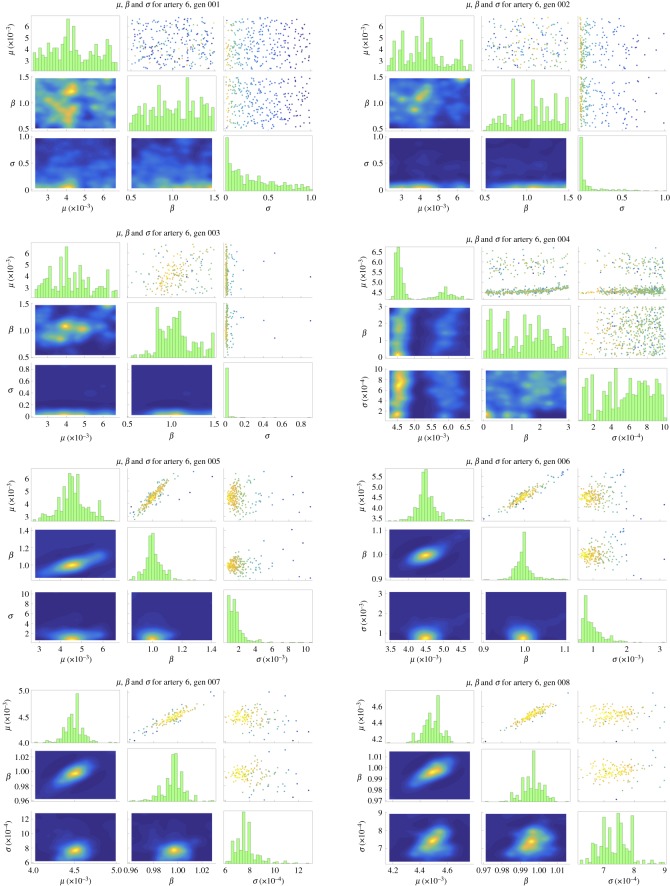
Samples from eight generations of TMCMC in §4.1. Plot limits are not constant (the sampled region of high probability monotonically decreases in size).